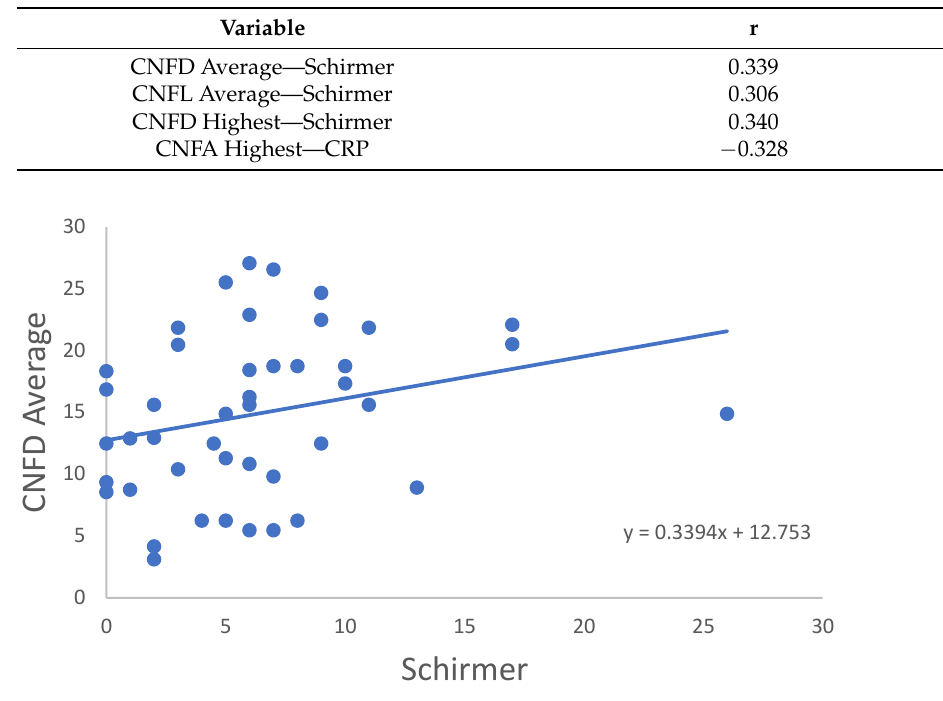
y = 0.3394x + 12.753